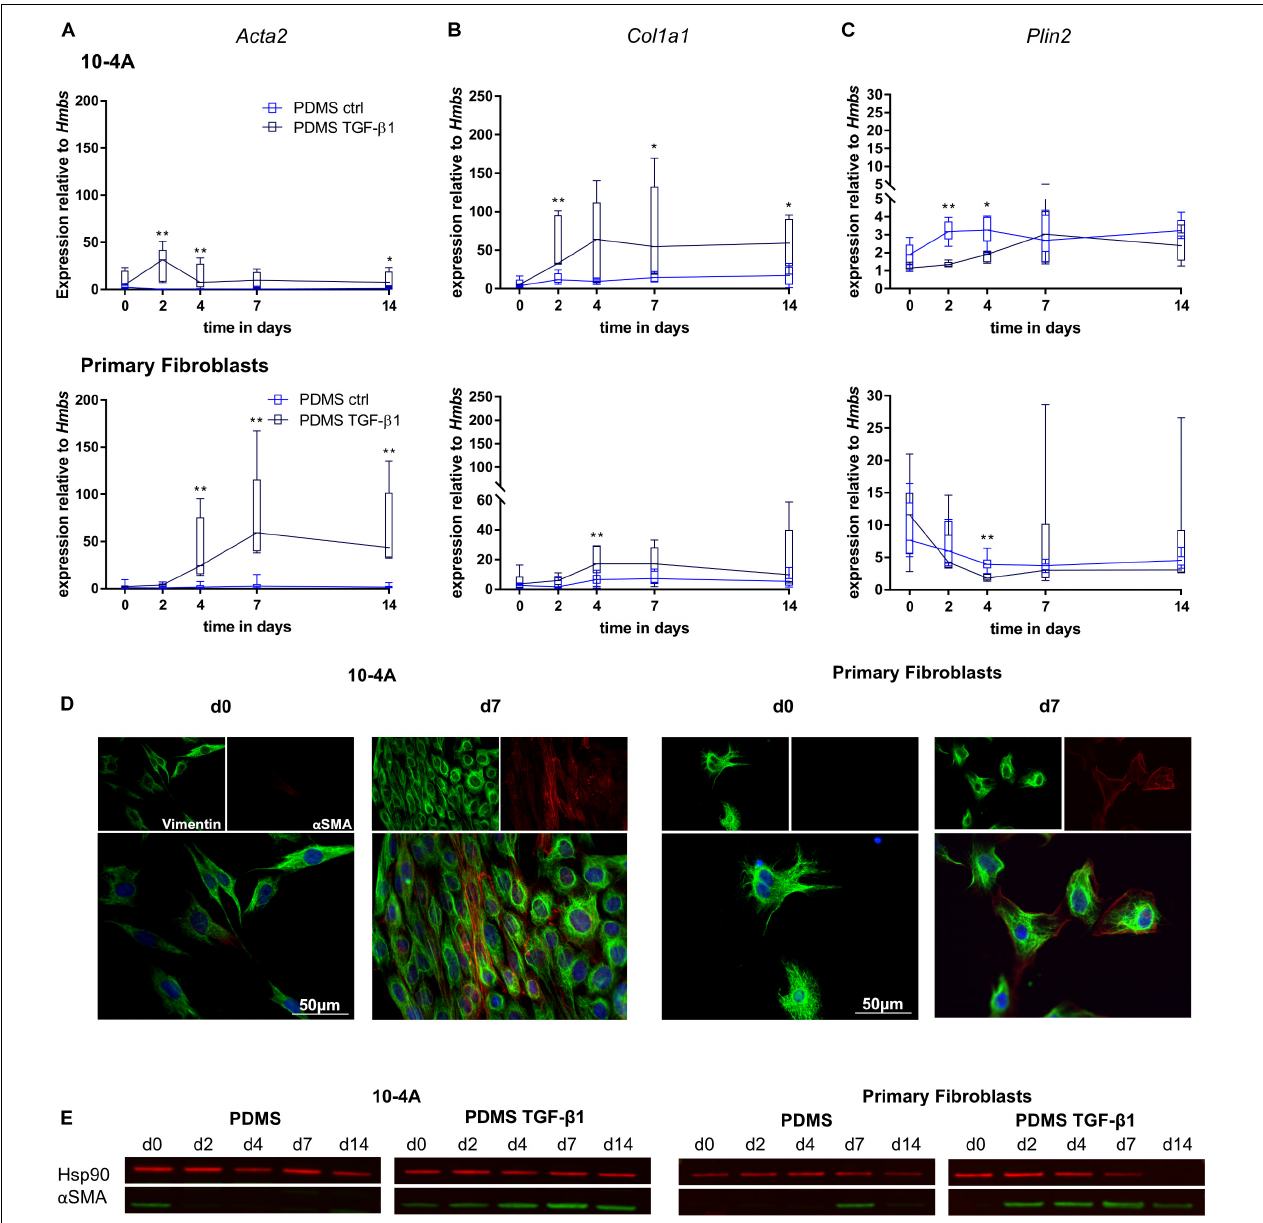
FIGURE 4 | Chemical stimulation of 10-4A cells and primary fibroblasts with TGF- β 1 on a physiological substrate. Semi-quantitative RT-PCR of Acta2 (A) , Col1a1 (B) , and Plin2 (C) expression in 10-4A cells (top graph) and primary fibroblasts (bottom graph) cultured in the presence or absence of 5 ng/ml TGF- β 1 on a soft PDMS substrate, respectively. Data are expressed as fold expression of housekeeping gene Hmbs . Primary fibroblast data were obtained from 5 different animals, 10-4A data from five independent passages. The respective time points were tested with the non-parametric Mann–Whitney- U -Test. Statistical significance is indicated as follows: p -values < 0.05: *, p -values < 0.01: **. Box plots show data as median values, the boxes represent percentiles, the whiskers indicate the minimum/maximum. (D) Immunofluorescence staining of 10-4A cells (left) or primary fibroblasts seeded on PDMS with administration of 5 ng/ml TGF- β 1 directly after adherence (d0) or 7 days post-seeding. Cells were stained for the mesenchymal marker vimentin (green) and the pro-fibrotic protein α SMA (red). Scale bar = 50 µ m. (E) Western Blot for α SMA in 10-4A cells and primary fibroblasts cultured over 14 days on PDMS substrate in the presence or absence of TGF- β 1, respectively. HSP90 was used as loading